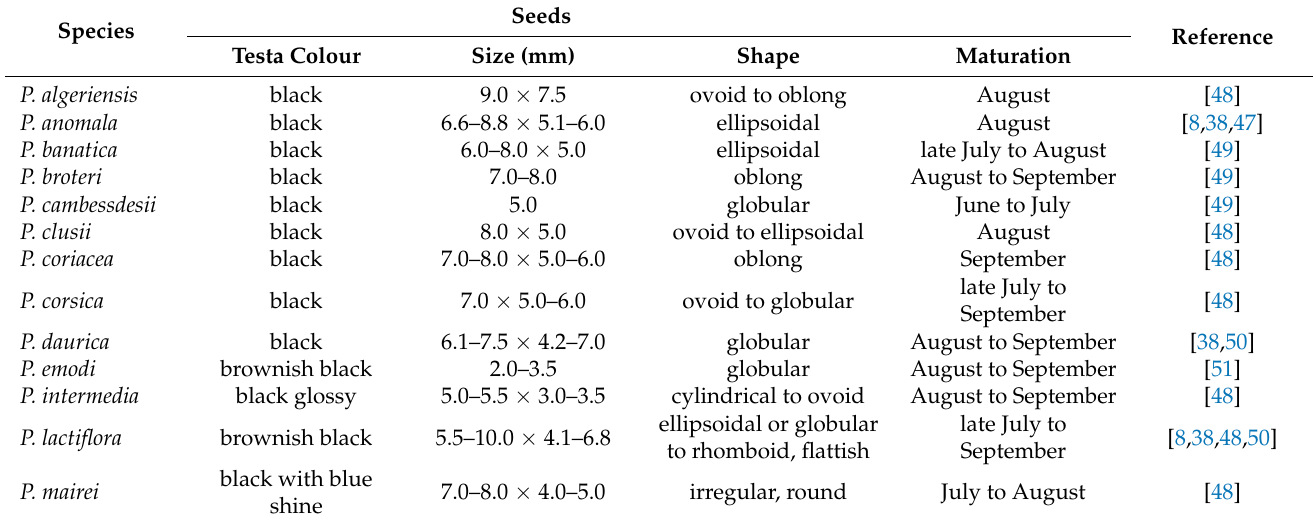
Table 1. Summarized literature data on seeds of most herbaceous peony